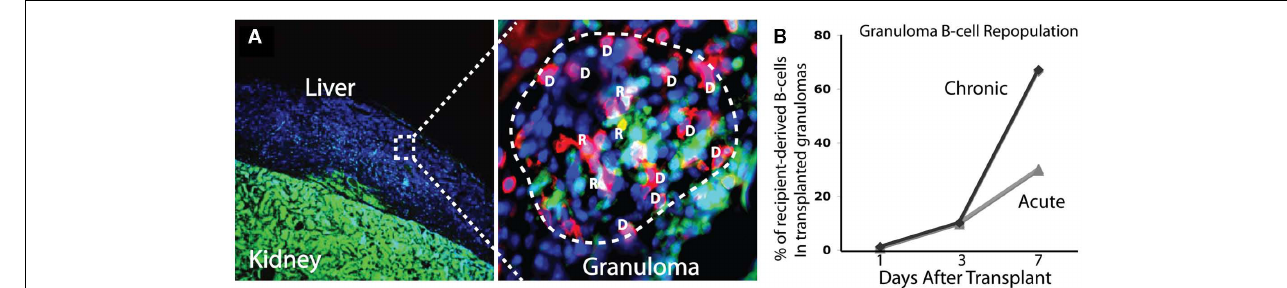
cells, while cell-specific signal alone identifies donor cells. In the image shown, donor cells are blue only (DAPI) or blue and red (donor CD4 + T-cell), while recipient cells are green (GFP) only or green and red (recipient CD4 + T-cell). Recipient B-cells repopulate chronic granulomas at a higher rate than acute granulomas (B) . Seven days after transplant, 2/3 of B-cells in transplanted granulomas are of recipient